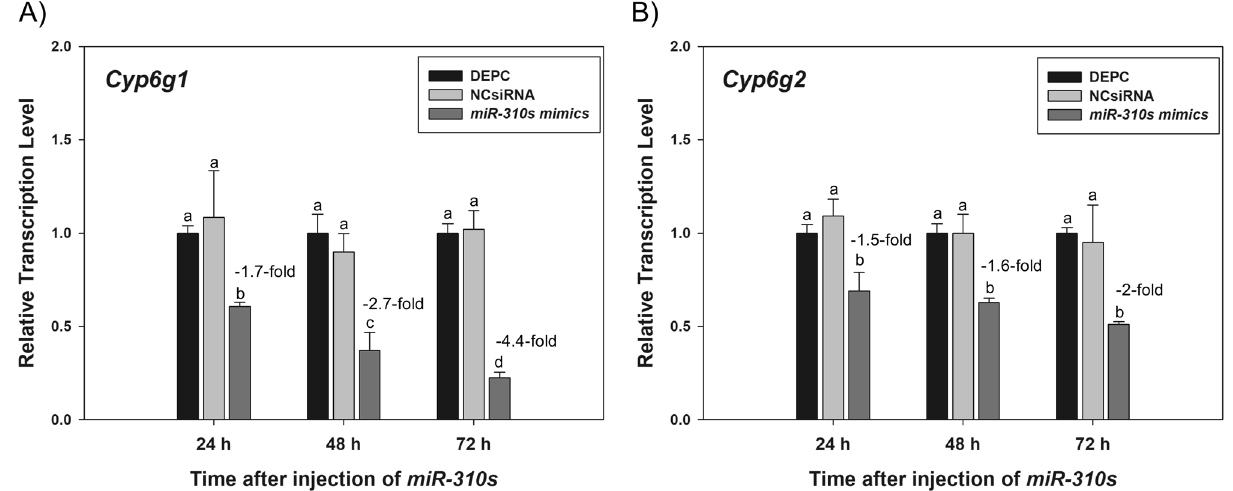
Figure 2. Relative transcription levels of ( A ) Cyp6g1 and ( B ) Cyp6g2 after microinjection of the miR-310s mimics, negative control siRNA (NCsiRNA) mimic, and DEPC-water into 91-R female flies at 24 h, 48 h, and 72 h post-injection. There was no difference between the DEPC-water and NC microinjection groups across three time points for Cyp6g1 ( p = 0.55) and Cyp6g2 ( p = 0.953). Different letters on the bars indicated that the means were significantly different across three time points ( p < 0.05).